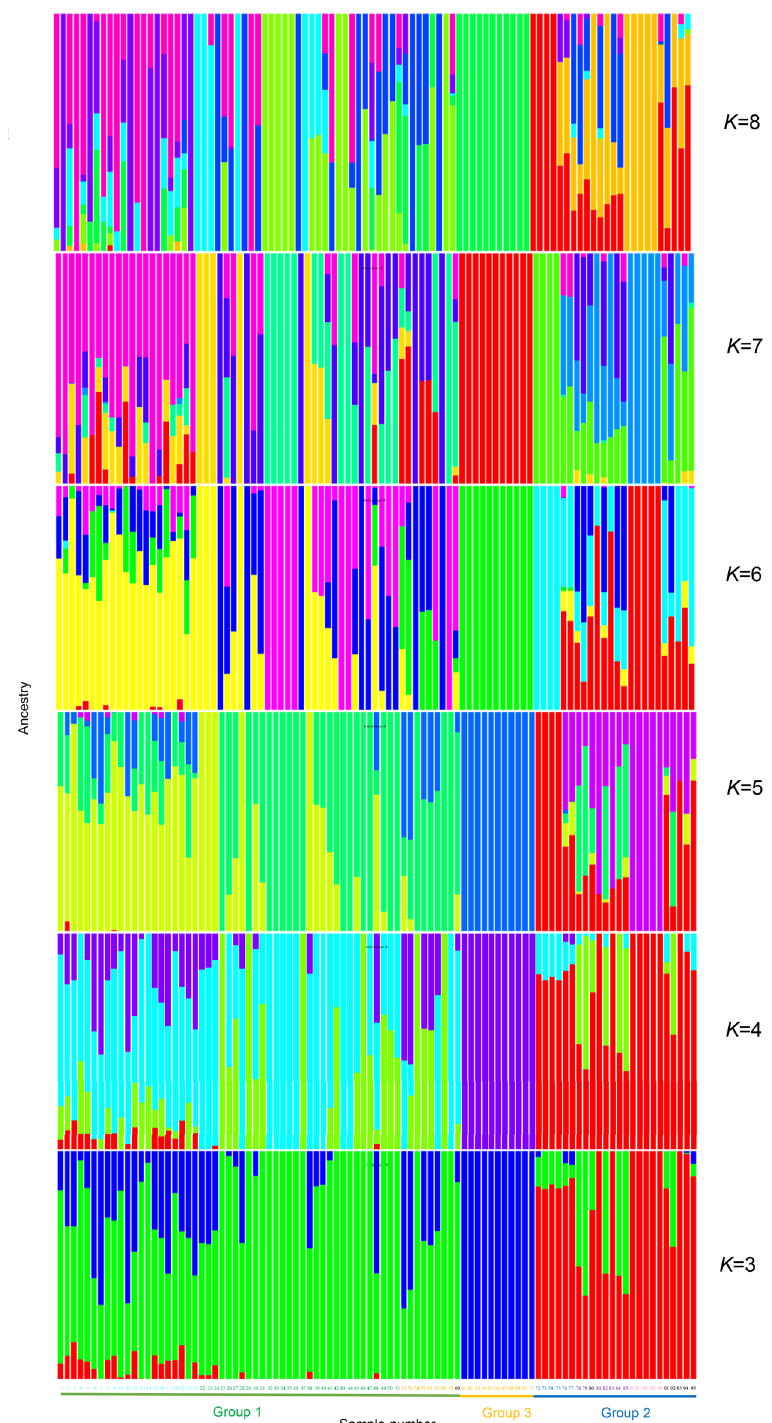
Figure 5. Admixture analysis of Eriobotrya japonica accessions. Admixture plots at K = 3 to 8 are shown. The colors for the sample numbers are the same as in Fig. 2. The figure was generated using R software (version